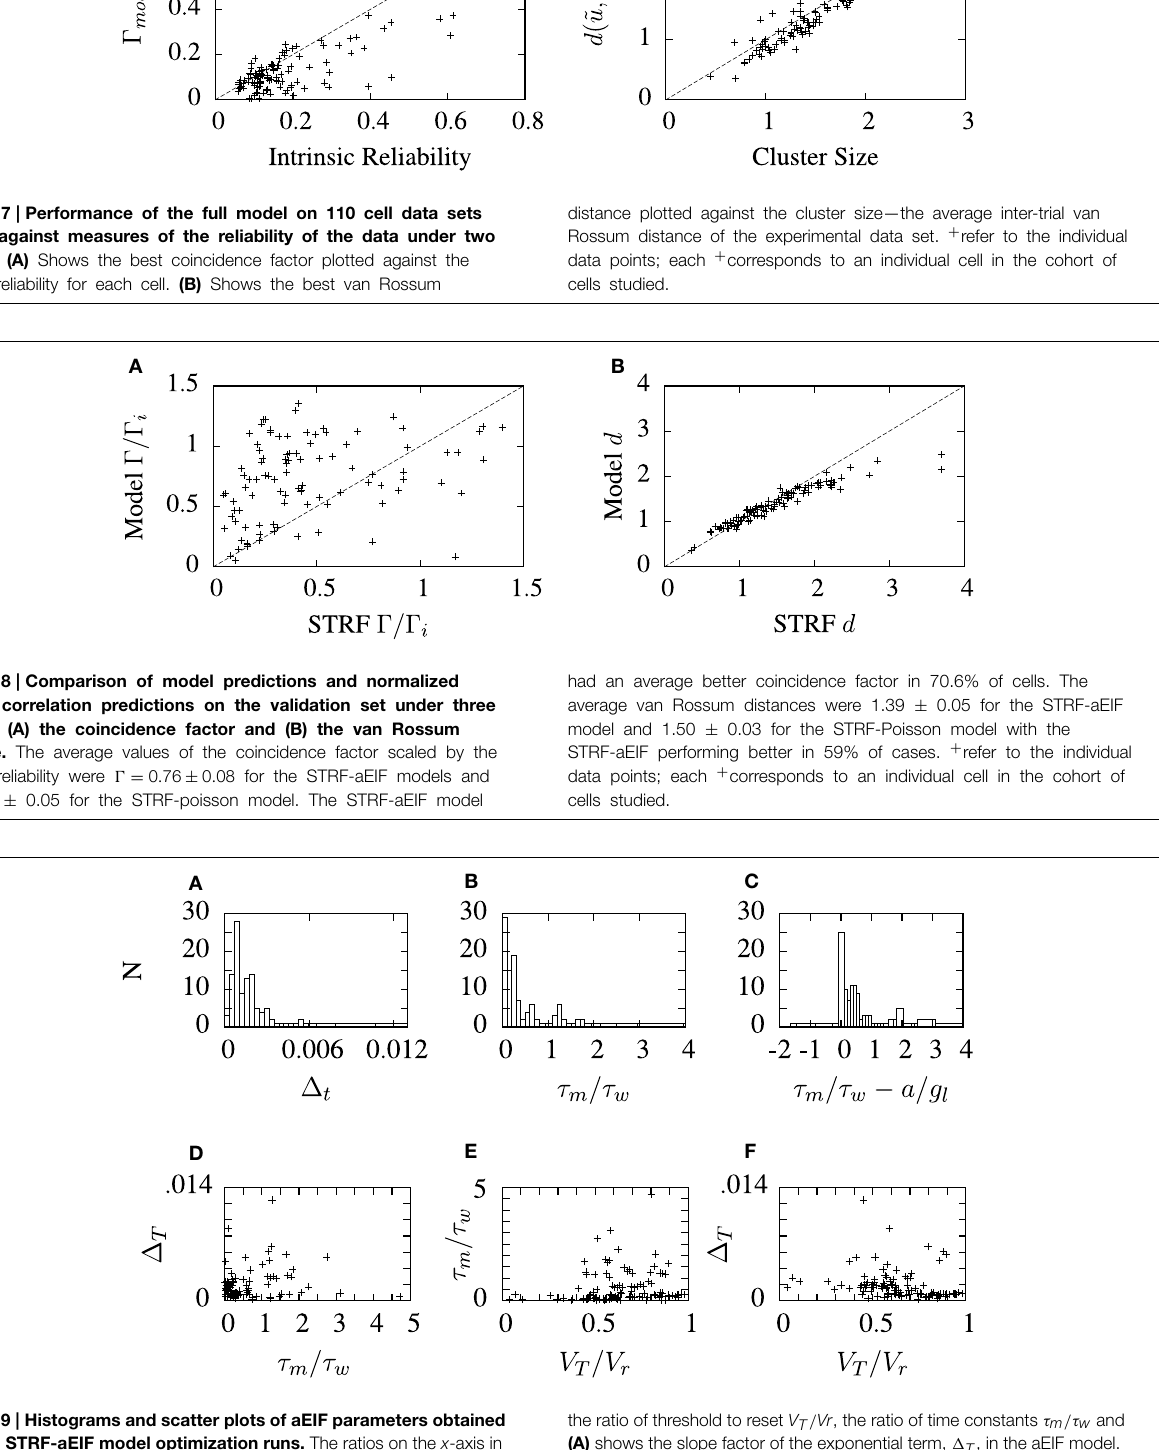
the ratio of threshold to reset V T / Vr , the ratio of time constants τ m /τ w and (A) shows the slope factor of the exponential term, 1 T , in the aEIF model. (D–F) show sample scatter plots of some of the parameters plotted against each other which were plotted to see if there may be any correlations